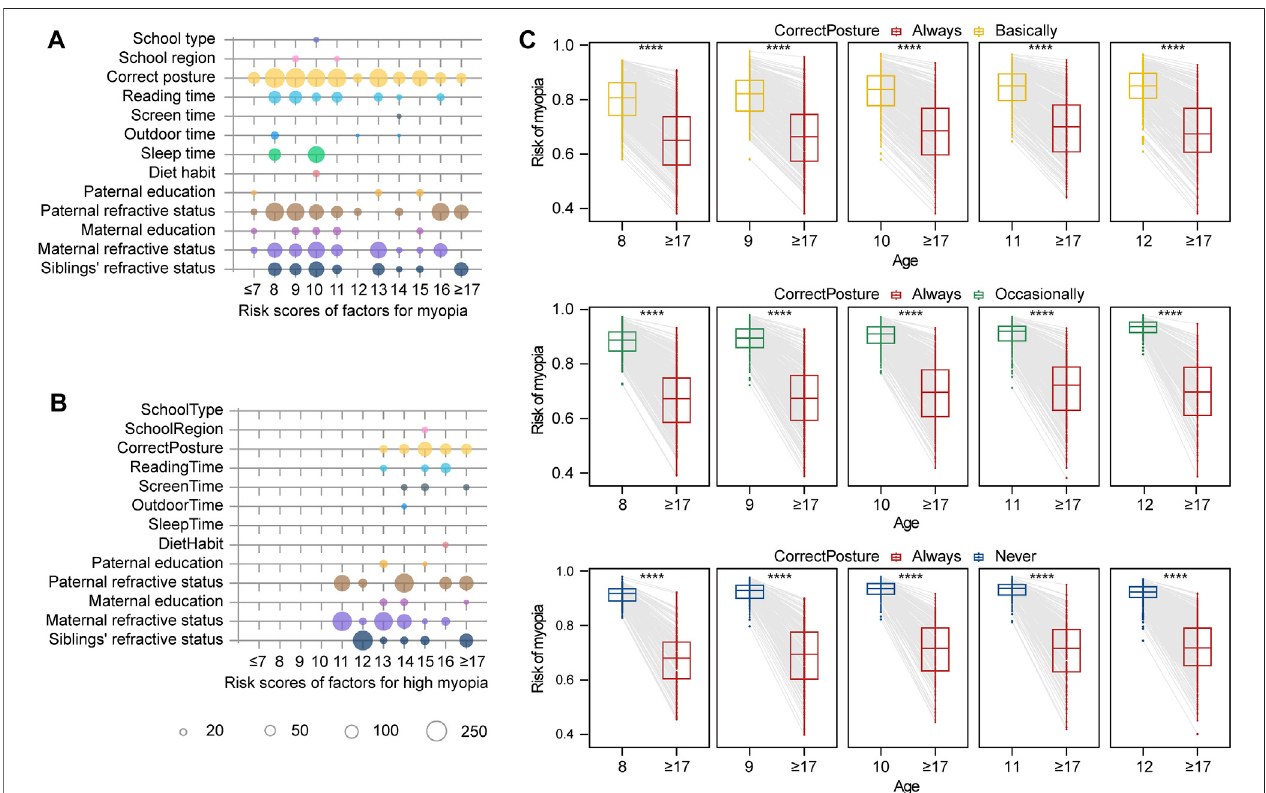
FIGURE 5 | Effect size of factors for myopia risk evaluation and simulated intervention models. (A) Risk scores for myopia according to age. The size of the circle indicates the effect size in modeling. (B) Risk scores for high myopia according to age. (C) Simulation of myopia risk by posture correction for different ages. In the fi rst rectangle,theboxchartontheleftrepresentstheriskofmyopiain8-year-oldchildrenwhokeepcorrectposturebasically.Theboxchartontherightrepresentstheriskof myopia in this group of children if they correct their posture at the age of eight and maintain correct posture until the age of 18 years. Four stars representing the difference of myopia risk between two groups are signi fi cant, with p <